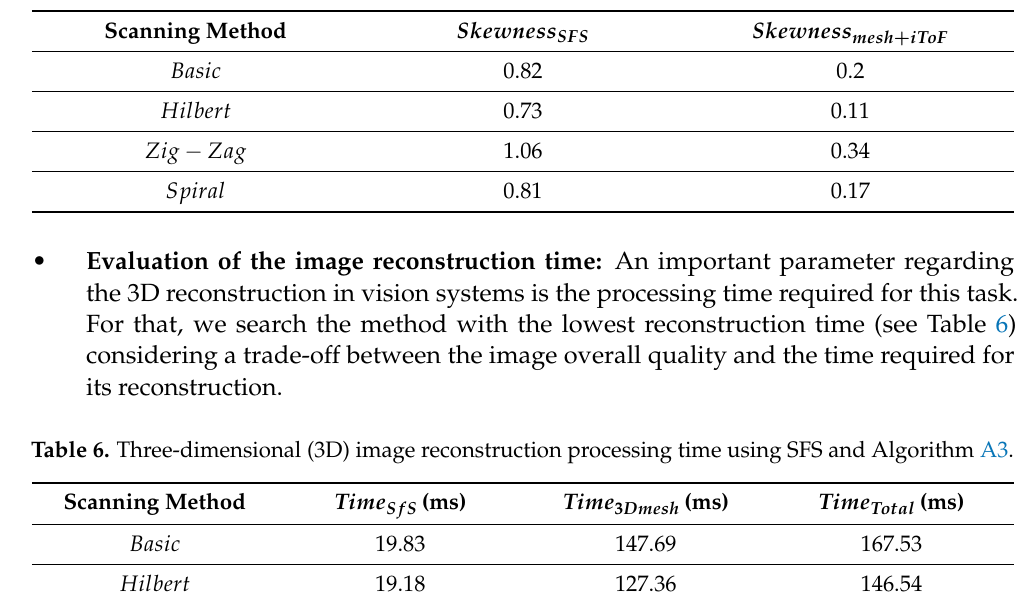
Table 5. Three-dimensional (3D) images perception of surface qualities fog conditions calculating the skewness.